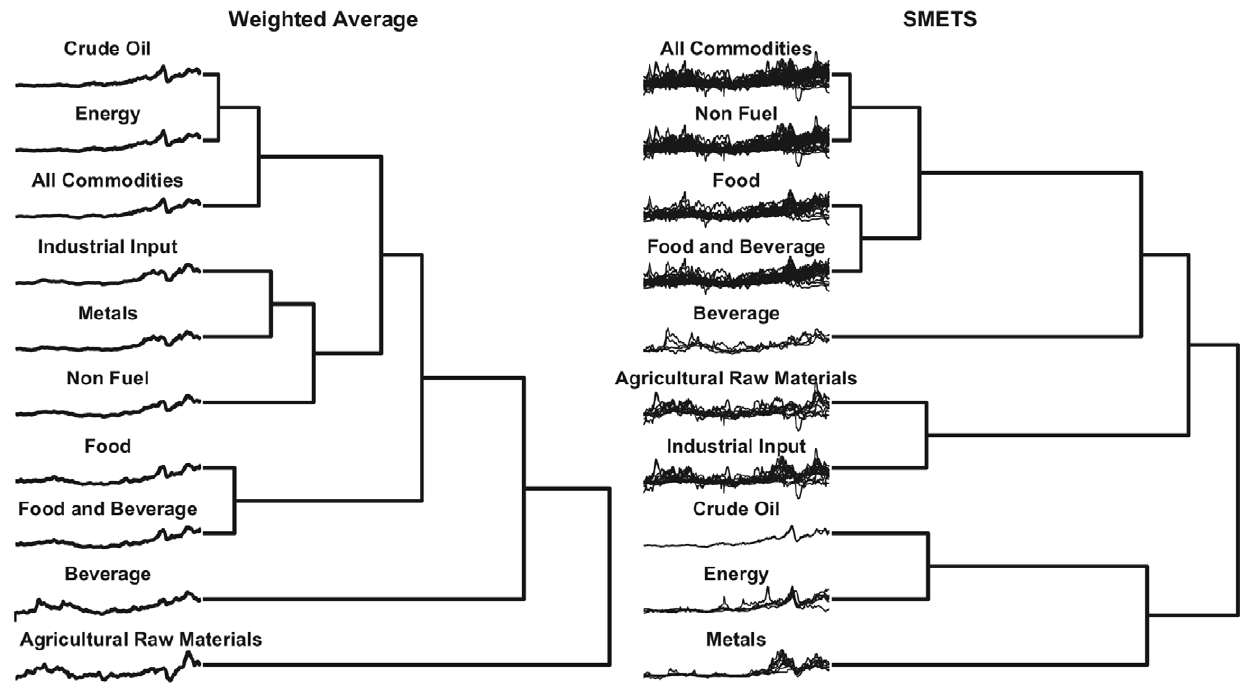
Figure 7. Hierarchical clustering of primary commodity prices. Distances were measured using the weighted average method versus SMETS. The dendrogram reveals the relative distances between each entity. The time series considered by each method are represented to the left.